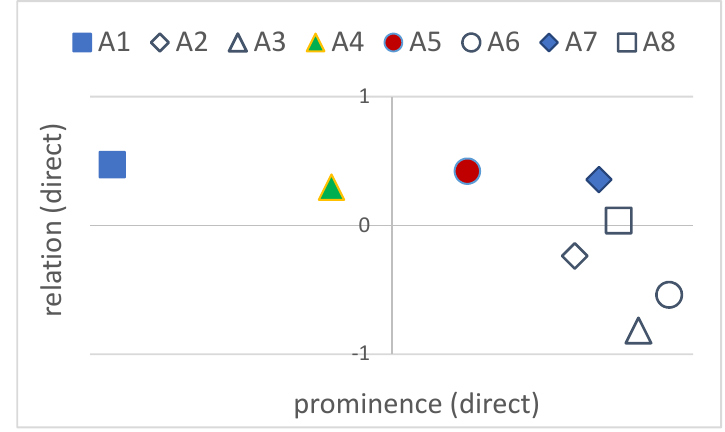
Figure 4. Results for full set of factors; the direct influence X case.